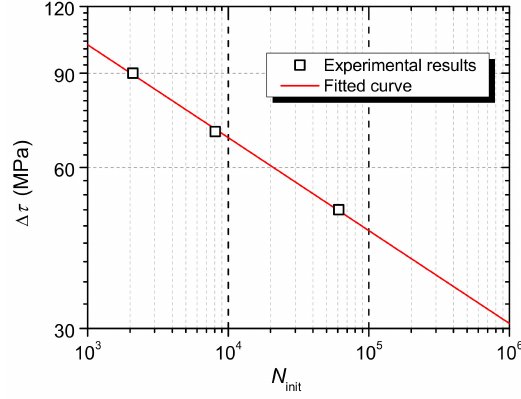
Figure 18. Crack initiation lives of shear